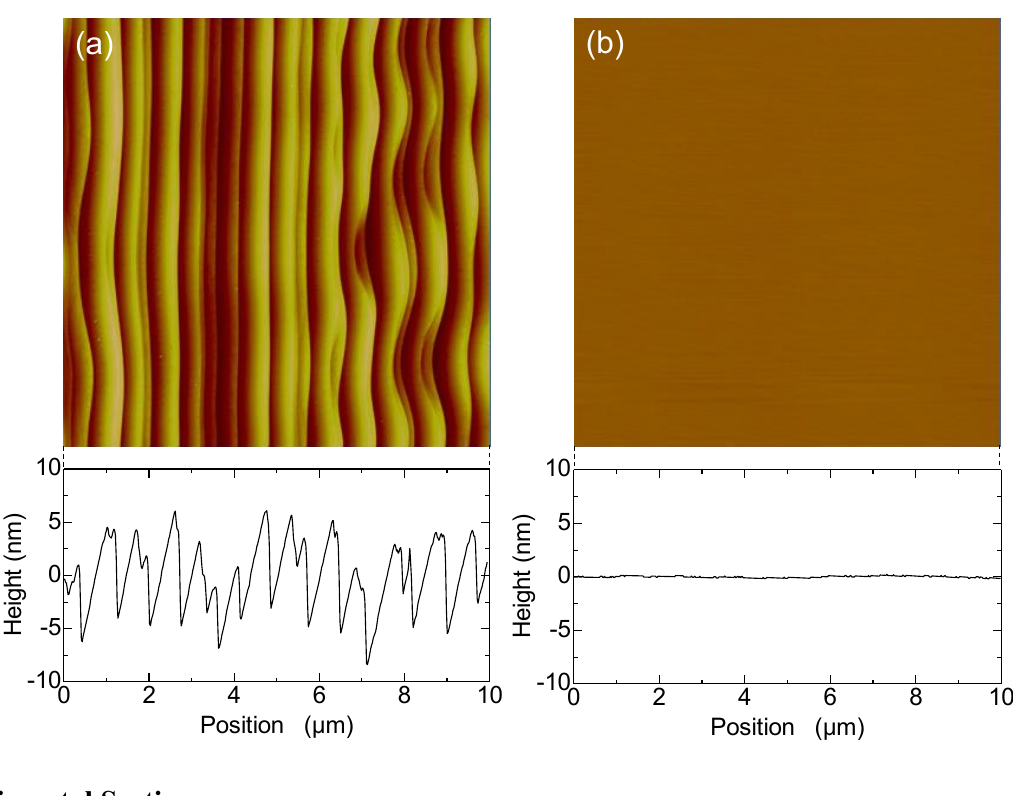
Figure 7. AFM images and the cross-sectional profiles of ( a ) as-grown and ( b ) chemical mechanical polishing (CMP)-treated epitaxial layers grown at a C/Si ratio of 2.0 with in situ etching to a depth of 1.2